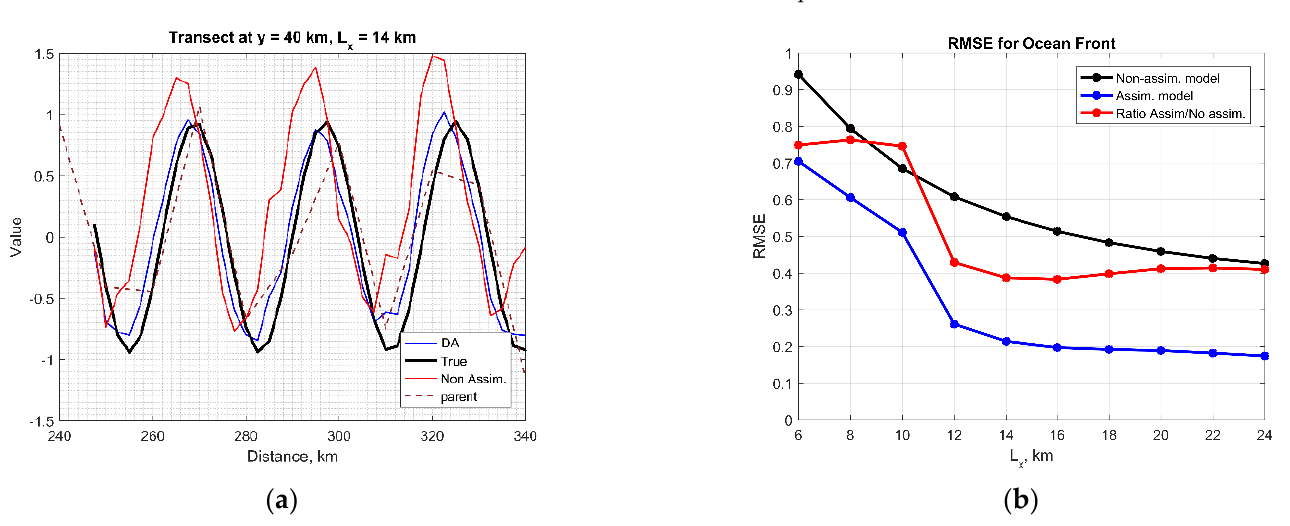
Figure 14. Ocean front case of L x = 14 km, with noisy parent model (added noise STD = 0.1) and noisy non-assimilated child model (added noise STD = 0.15, bias = 0.3 and shift of 4 km to the west). ( a ) Transects at y = 100 km of assimilated (blue), non-assimilated (red) child models, and the true field (black), ( b ) RMSE calculated for non-assimilated (black) and assimilated (blue) child models and the ratio between them at different front steepness.